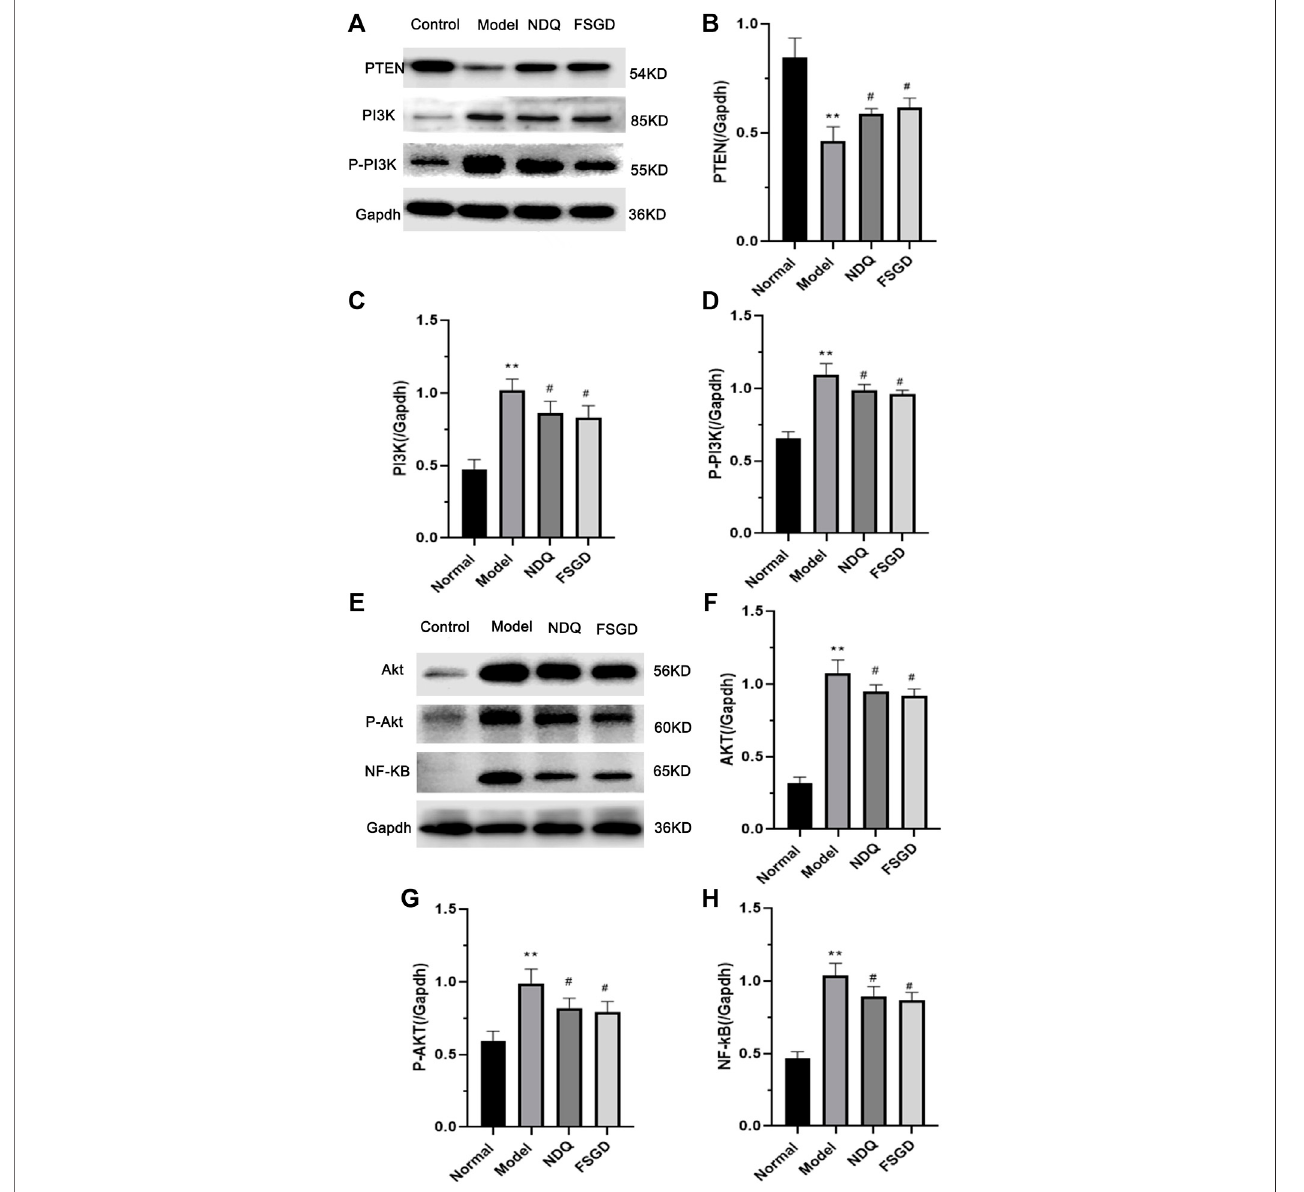
FIGURE7| TheproteinanalysisofPi3k/Aktpathway forFSGDinCRF. (A,E) WesternblottingofPTEN,PI3K,p-PI3K,AKT,p-AKTandNF- κ Binthekidney.[ (B – D) and (F – H) ] The relative expression concentration analysis for PTEN, PI3K, p-PI3K, AKT, p-AKT and NF- κ B in the kidney. Compared with the normal group, * p < 0.05, ** p < 0.01; versus normal group; ## p < 0.01, # p < 0.05, compared with the model group, respectively.